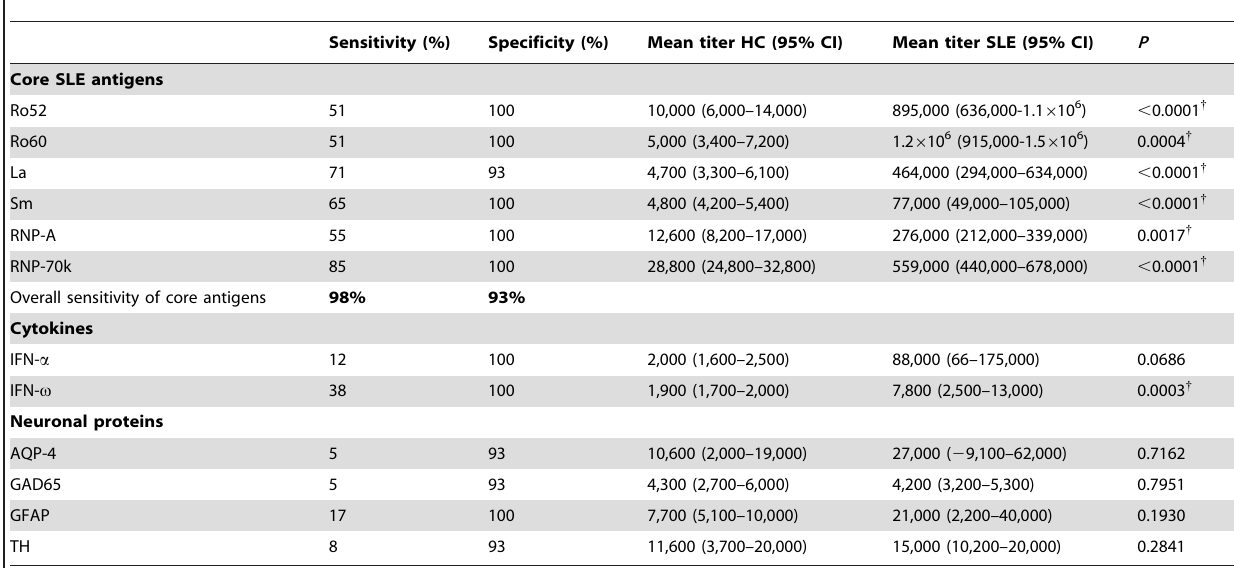
Table 2. Sensitivity and specificity of Ruc-antigen fusions in an independent validation cohort.